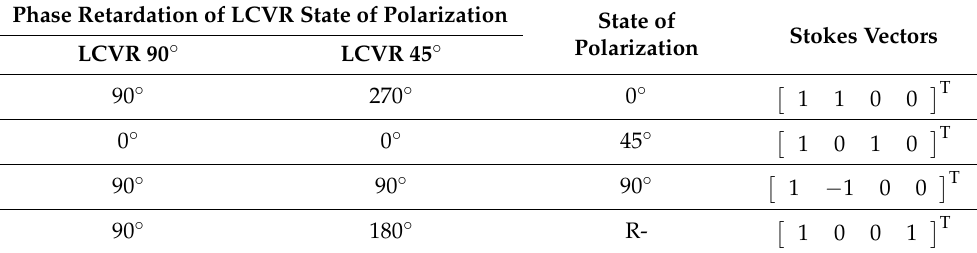
Figure 2. Schematic illustration of dual ‐ retarder Mueller polarimetry system. Table 1. Output polarization states generated by dual-retarder Muller polarimetry system.